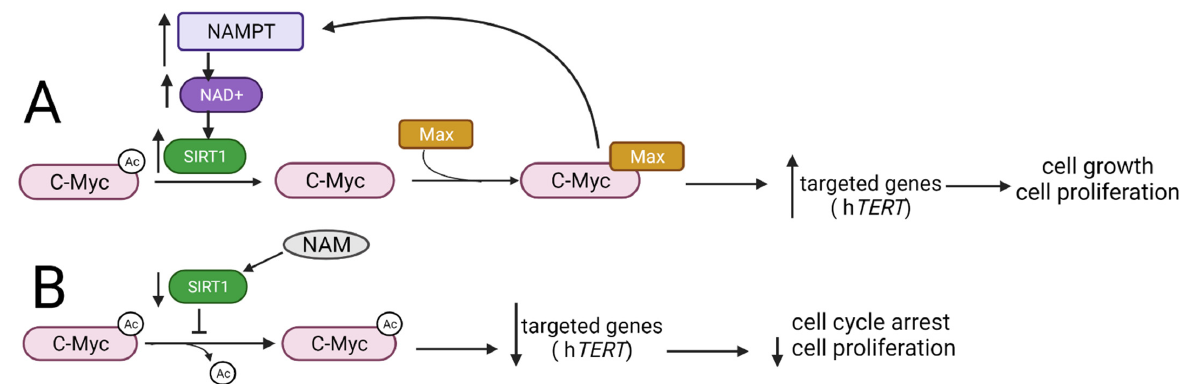
Figure 6. The interplay between SIRT1 and Myc proteins. ( A ) SIRT1 deacetylates C-Myc and thus enables the formation of C-Myc/Max heterodimers, resulting in C-Myc transactivation, followed by an increased expression of its target genes and thus stimulation of cell growth and proliferation. Simultaneously, C-Myc stimulates the activity of SIRT1 by inducing the expression of the NAMPT gene encoding the enzyme responsible for the production of the SIRT1 cofactor NAD + . ( B ) The use of the NAM leads to the inhibition of SIRT1 activity and thus inhibits C-Myc protein deacetylation, decreases the expression of target genes, and results in cell cycle arrest. NAMPT—nicotinamide-phosphoribosyltransferase; NAD + —nicotinamide adenine dinucleotide; hTERT—human telomerase reverse transcriptase; NAM—nicotinamide.